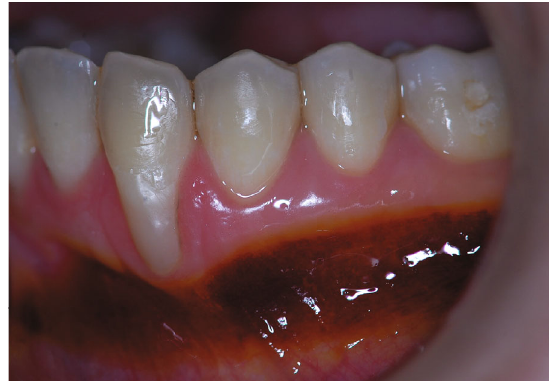
Figure 3: Iodine solution staining revealed the presence of approximately 3 mm of keratinized tissue at the donor area distal to the defect. This area was not adequate for an